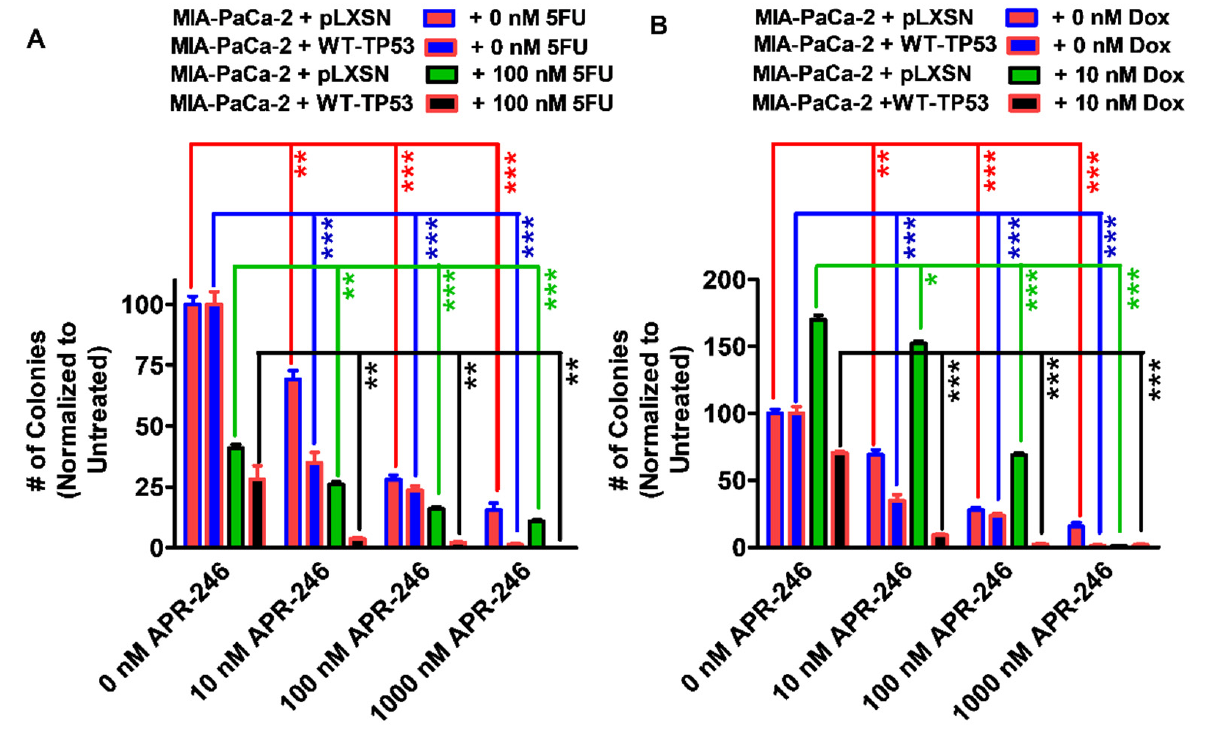
Figure 6. Effects of APR-246 on clonogenicity of MIA-PaCa-2 + pLXSN and MIA-PaCa-2 + WT-TP53 cells in the presence and absence of low doses of 5FU or doxorubicin. The effects of ABR-246 on clonogenicity in the presence of low doses of 5FU (Panel ( A )) or doxorubicin (Panel ( B )) were examined, with MIA-PaCa-2 + pLXSN in the absence of either 5FU or doxorubicin (red bars), MIA-PaCa-2 + WT-TP53 in the absence of either 5FU or doxorubicin (blue bars), MIA-PaCa-2 + pLXSN in the presence of APR-246 and 5FU or doxorubicin (green bars), and MIA-PaCa-2 + WT-TP53 in the presence of APR-246 with either 5FU or doxorubicin (black bars). In each condition, the cells were plated in 3 wells of a 6–well plate, and cells in each panel were all examined at the same time period. *** = p < 0.0001, ** p < 0.005, and * p < 0.05.